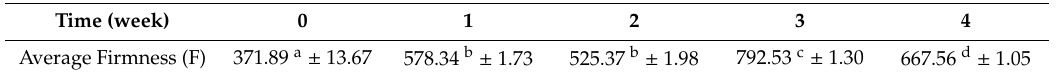
Table 6. Firmness of sponge cakes in accelerated condition 37 °C.